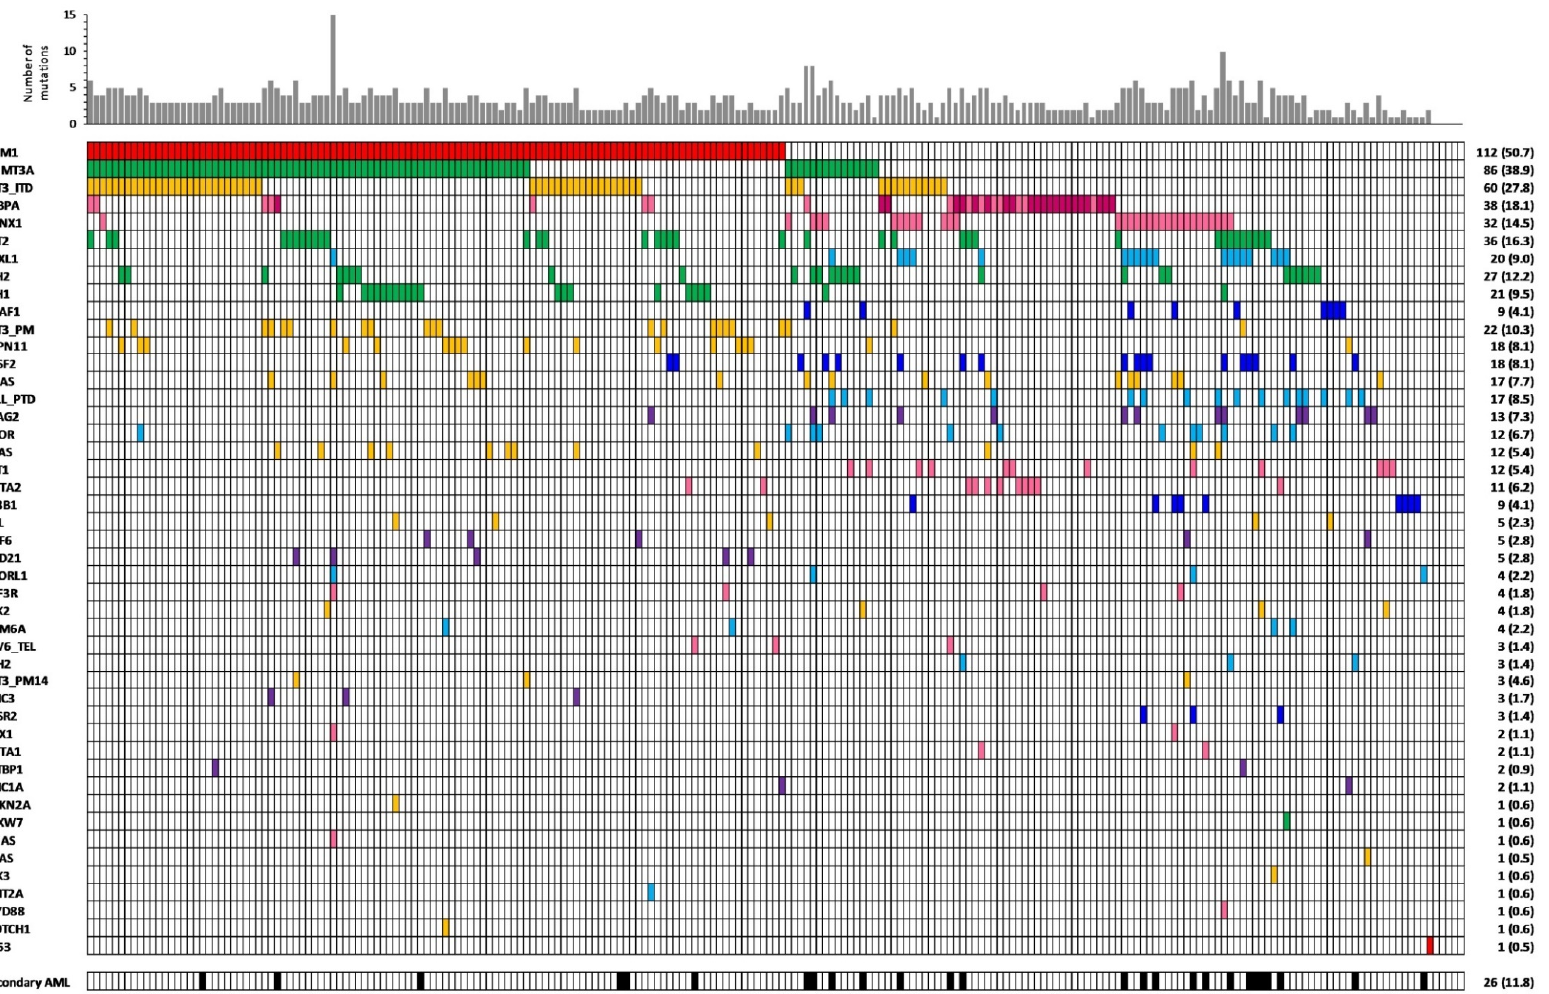
Figure 3. Frequency of different mutated genes in our cohort of patients. In CEBPA line, dark pink indicates the presence of a double mutation.